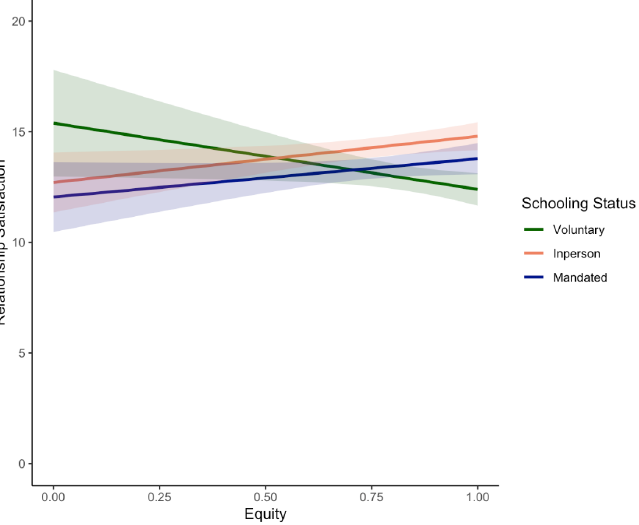
Figure 4. Simple slopes analyses demonstrating the interaction between equity and schooling status on parents’ relationship